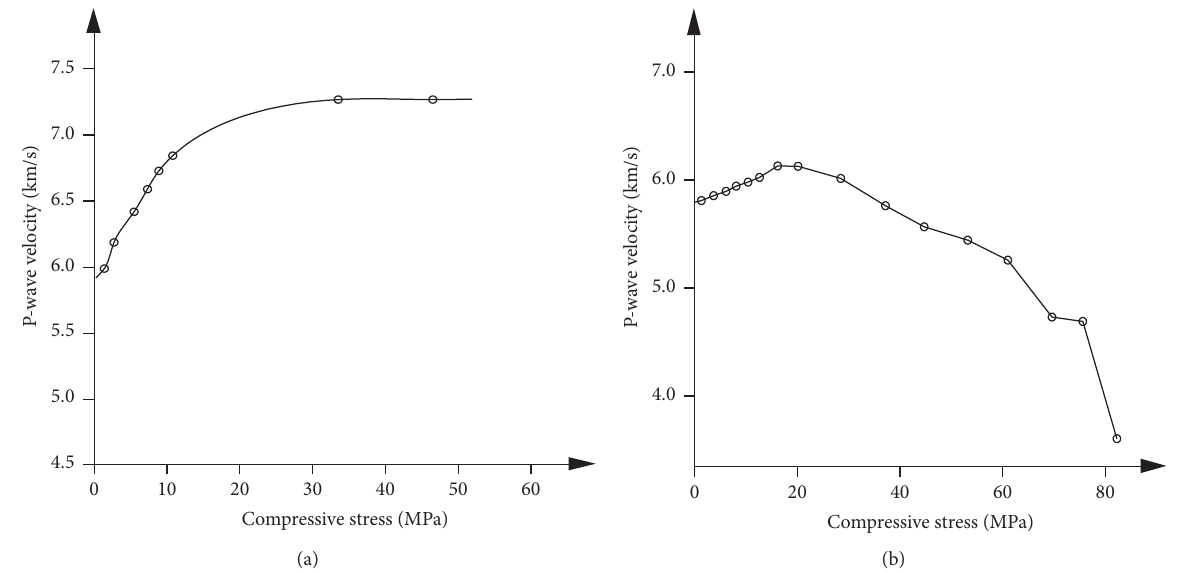
Figure 3: Variation curve of pressure wave velocity. (a) P-wave velocity along the direction of compressive stress. (b) P-wave velocity perpendicular to the direction of compressive